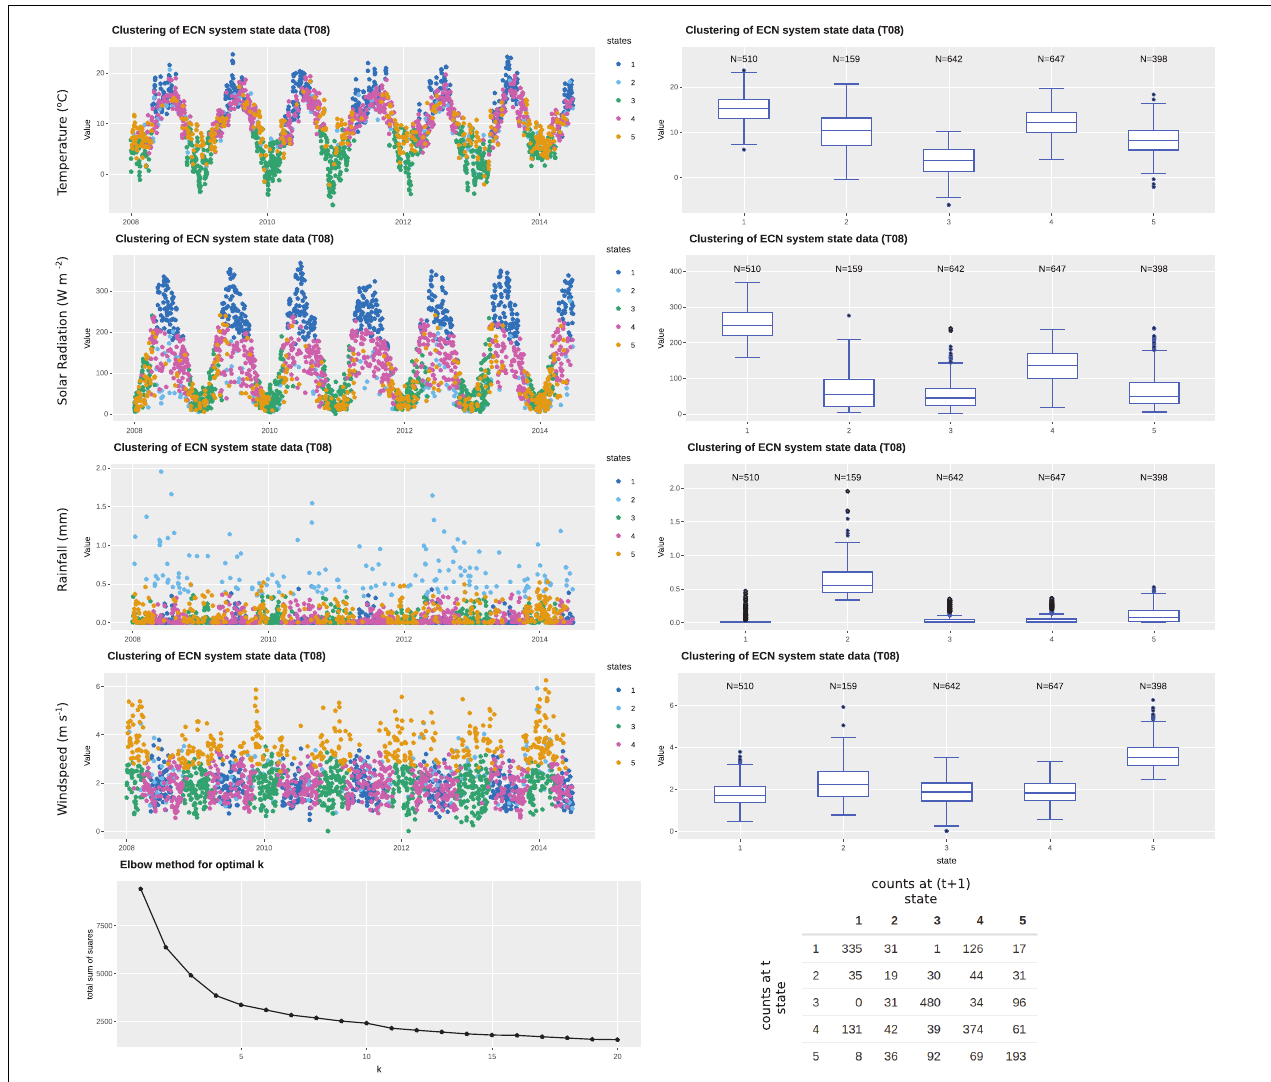
FIGURE 3 | Example of state tagging at the ECN site at Wytham. A box-and-whisker plot is linked to the time series and shows the statistics of the selected state variable for each cluster. An elbow plot is useful to optimize the number of clusters used and avoid overfitting. A t vs. (t+1) matrix is useful to explore the autocorrelation of